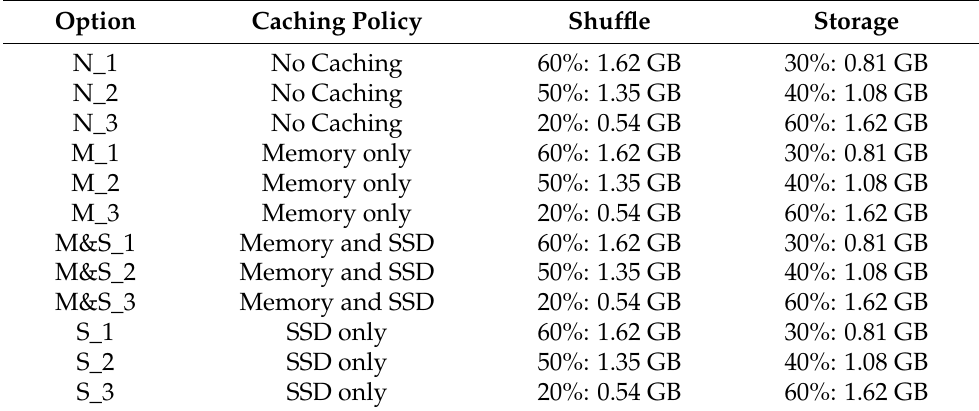
Table 3. Experimental configurations: Spark JVM heap and RDD caching